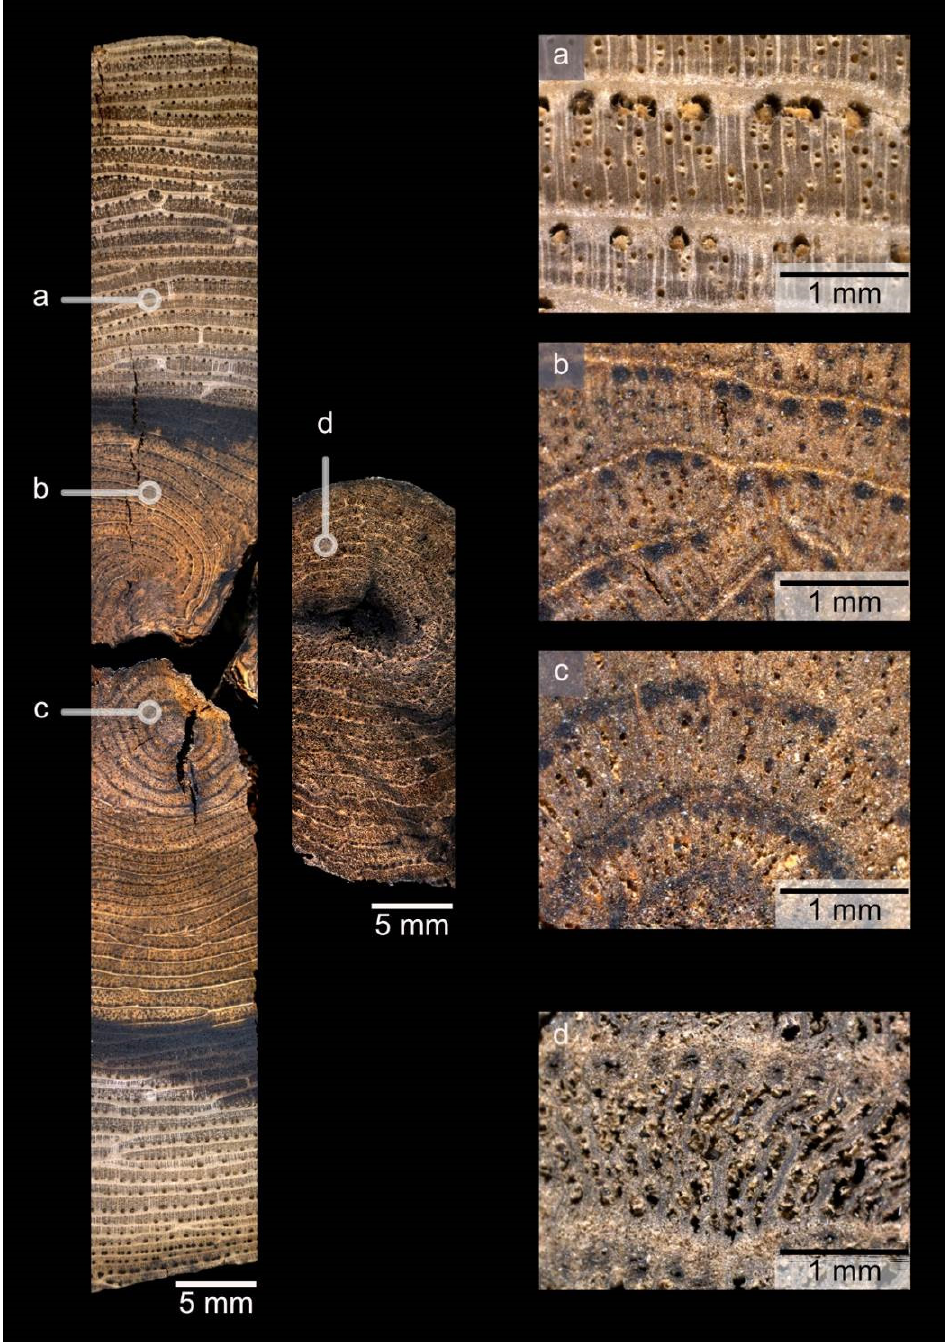
Figure 5. Thick sections in transverse section at 1.0× magnification of recent Avicennia marina wood (left) for comparison with the subfossil trench wood (center). The right column shows details of the recent Avicennia marina wood ( a – c ) and the subfossil trench wood ( d ), all at 5.0× magnification.